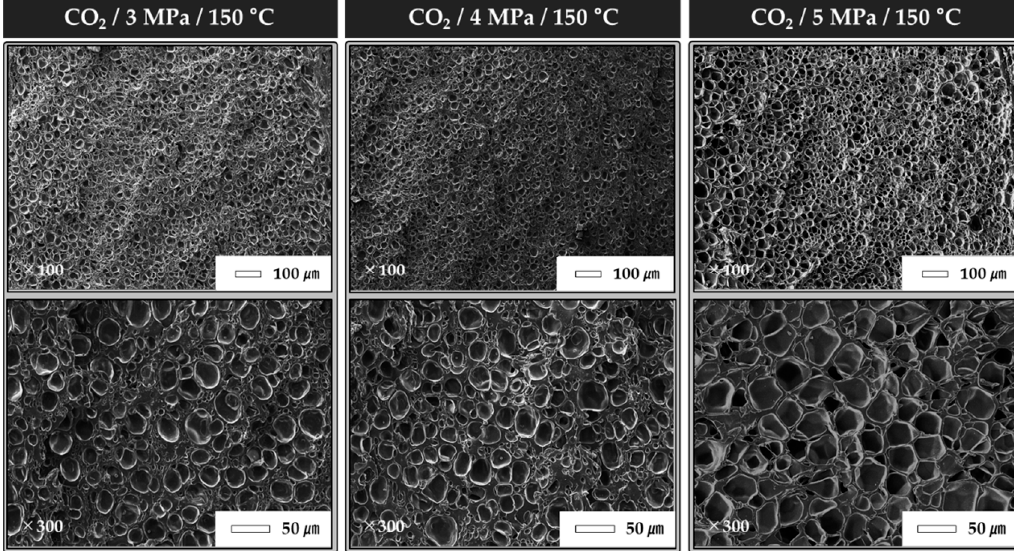
Figure 6. Cross-sectional SEM images of TPU specimens at different saturation pressures.